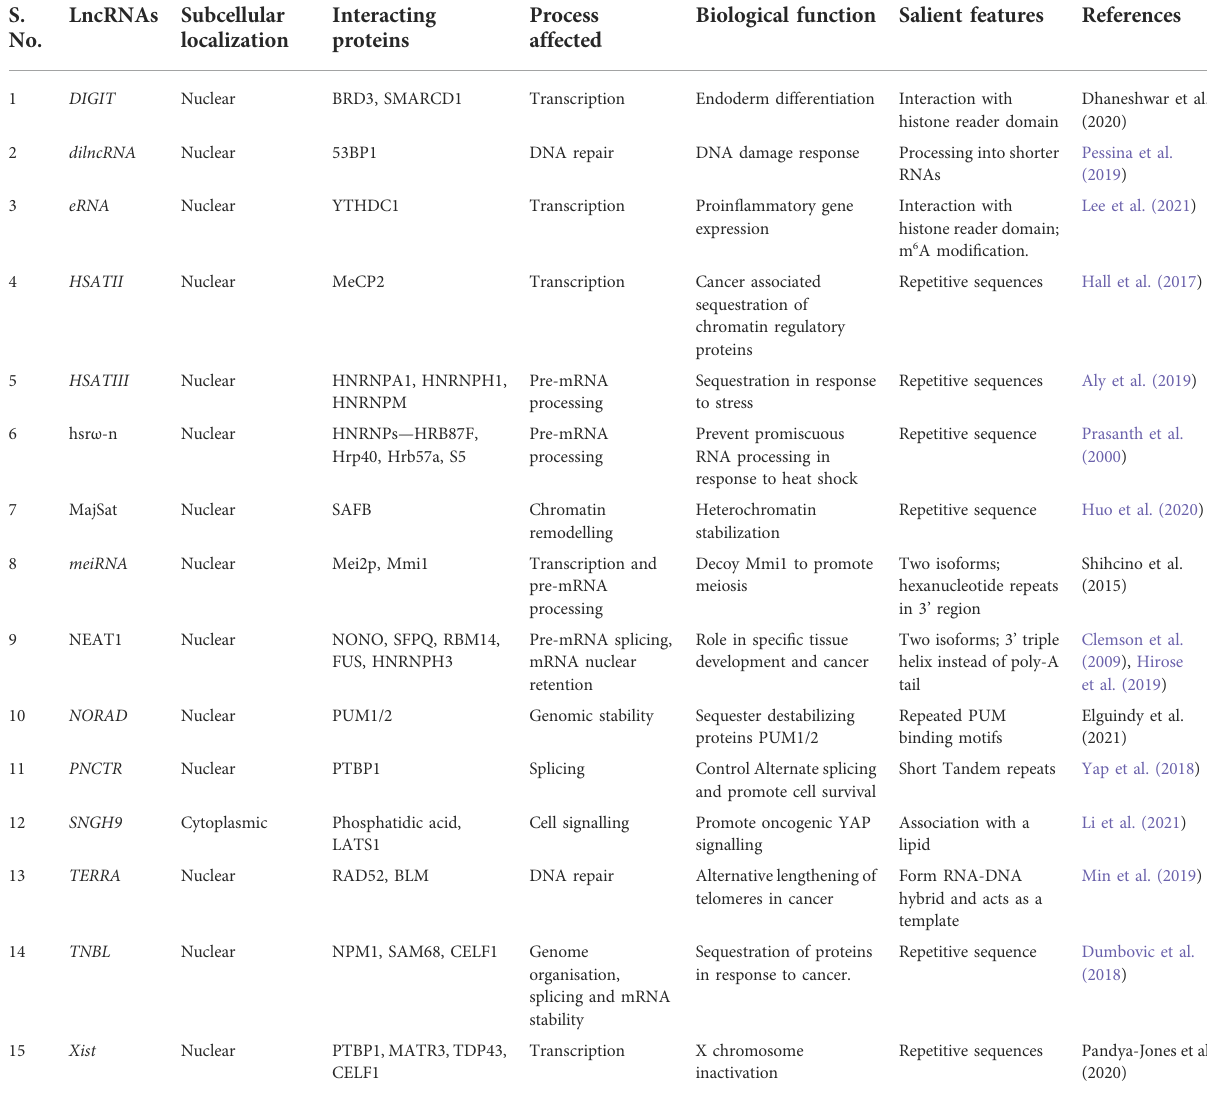
TABLE 2 LncRNAs that are associated with phase